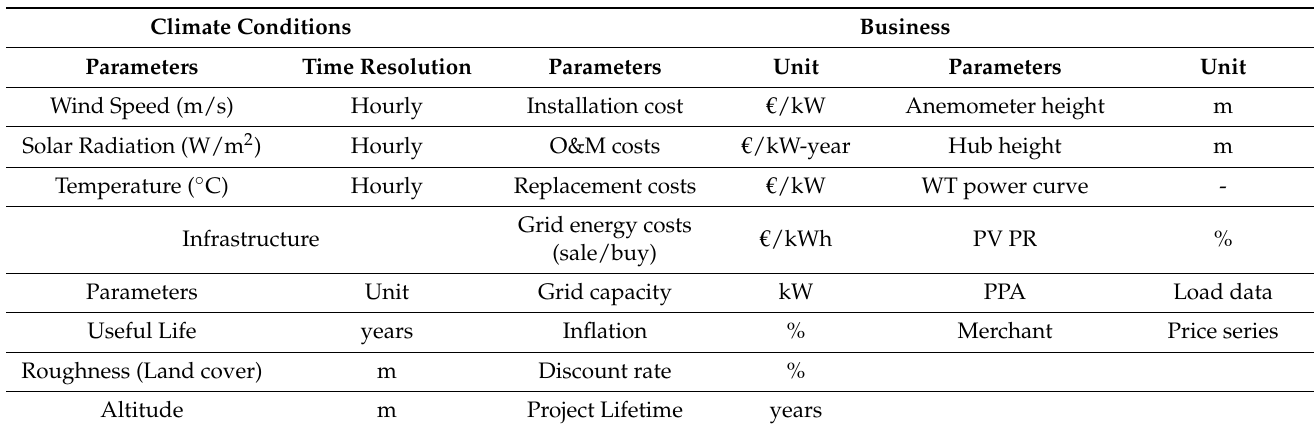
Table 2. Hybrid Optimization Model for Electric Renewables (HOMER) Data structure as a reference for Production cost assessment level under the microgrid (MG) layer